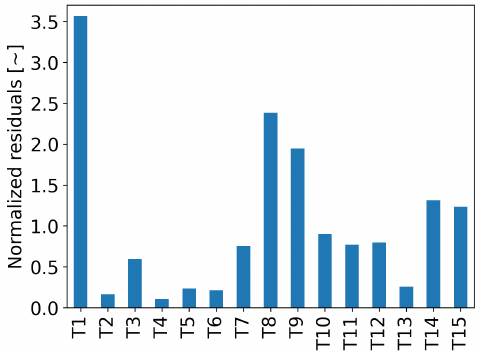
Figure 16. Iterative model: bar plots of MAE residuals (December 2020).